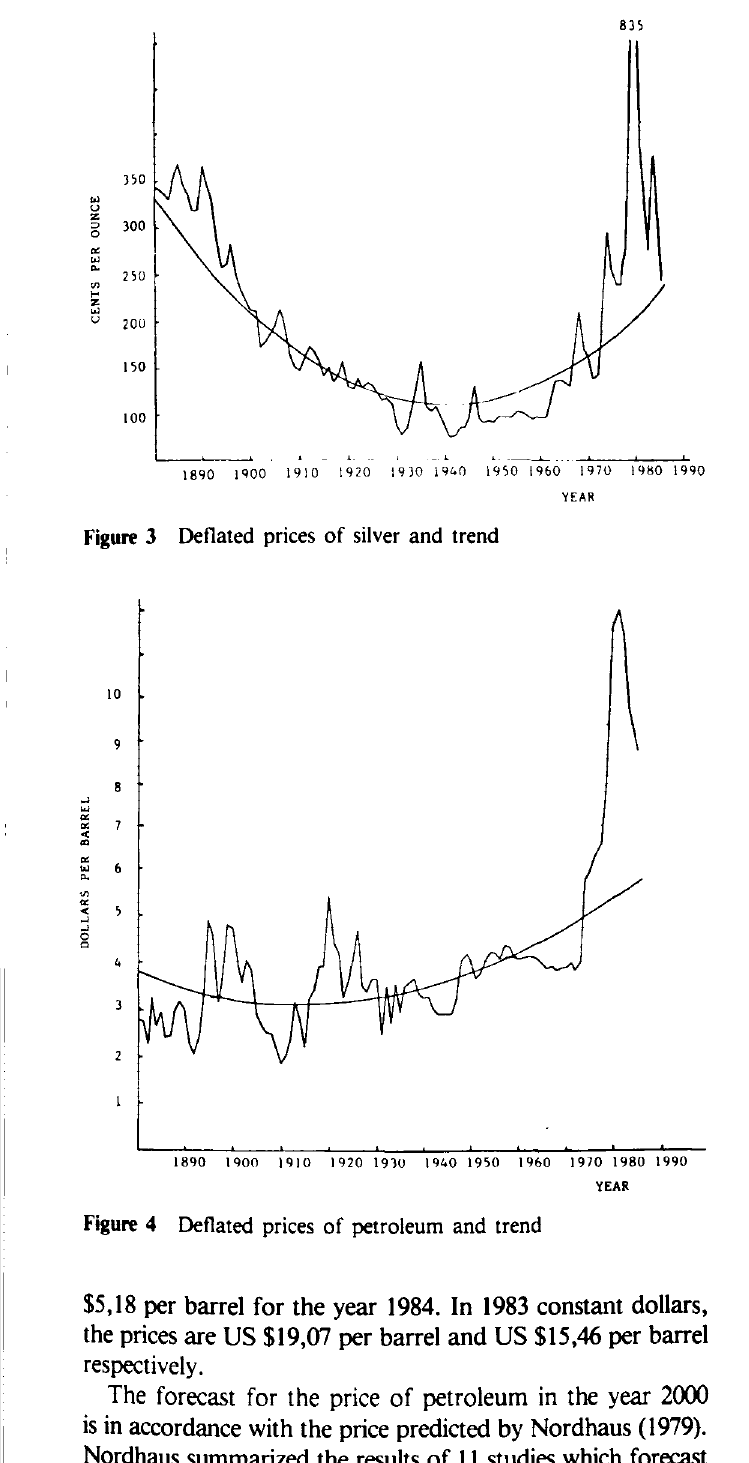
Figure 3 Deflated prices of silver and trend